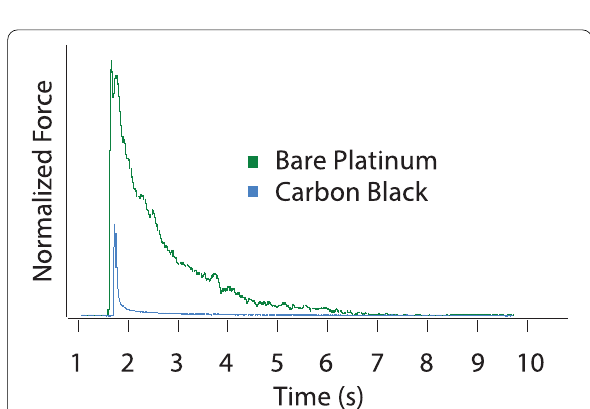
Fig. 10 Example of raw force output comparing carbon with bare platinum. Representative examples, based on median force-time integral, of onset at BT. Square blocking waveform at 20 kHz, comparing bare platinum (green) and carbon black-coated platinum (blue). Force normalized to PS peak height, onset time staggered for